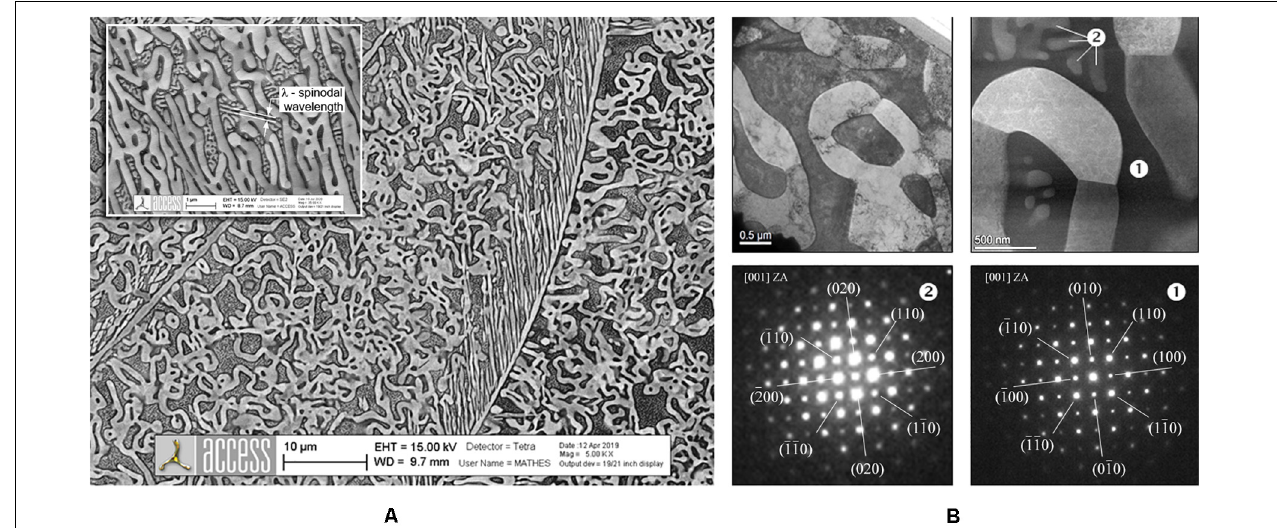
FIGURE 2 | SEM (A) and BFTEM as well as STEM (B) micrographs of an as-cast AlCrFe 2 Ni 2 sample featuring the ultrafine vermicular microstructure of FCC-A1 in a spinodally decomposed BCC matrix. The product phases of the spinodal decomposition are labeled (cid:172) (BCC-B2#) and (cid:173) (BCC-A2). Diffraction patterns taken along a [001] zone axis show subtle difference in the intensity of the {100} planes, relative to the {110} planes, when comparing BCC-B2# and BCC-A2# phases. Note the high dislocation density in the FCC-A1 phase as well as sub-grain boundaries.